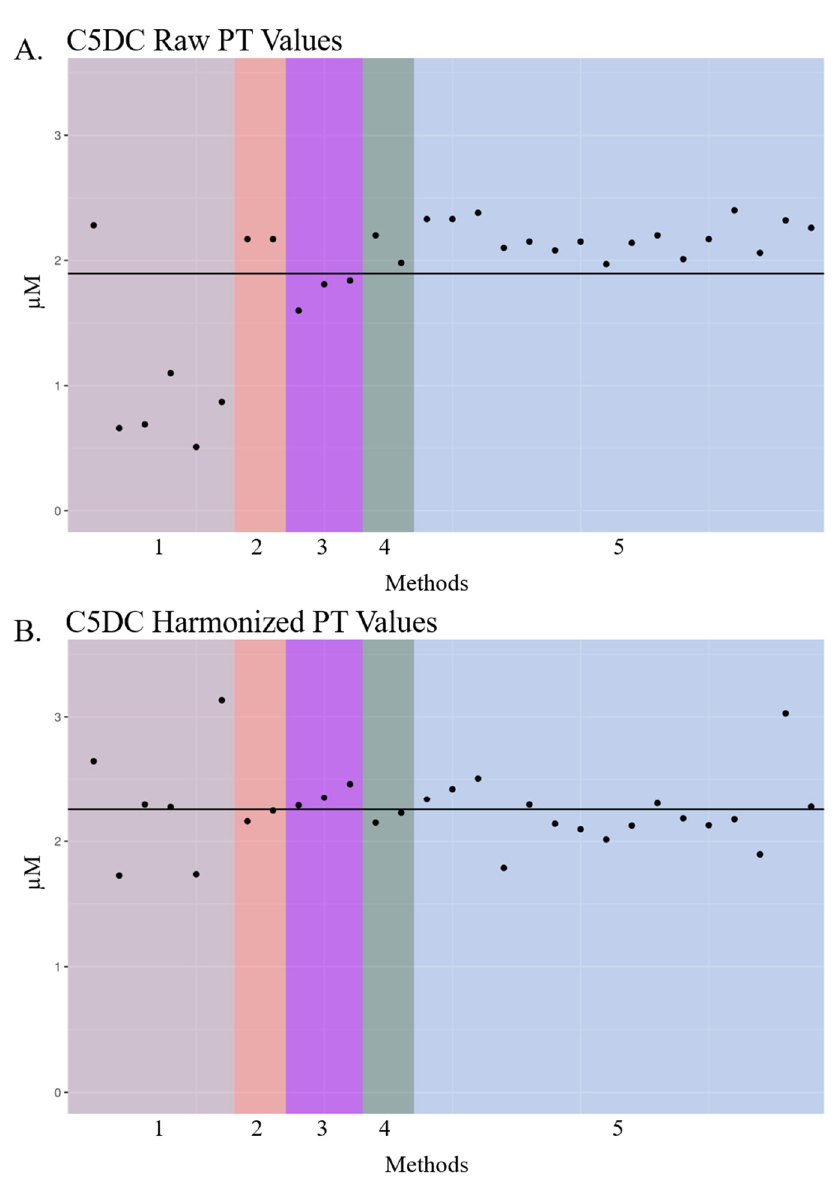
Figure 2. Dot plot of glutarylcarnitine (C5DC) proficiency test raw and harmonized data across US public health newborn screening (NBS) labs from 2019. Dot plots of raw ( A , B ) harmonized glutarylcarnitine (C5DC) proficiency test (PT) data reported by US public health NBS laboratories in 2019. Laboratory names are de-identified. Laboratory PT values are grouped by analytical method, and these unique methods are denoted by color and number. Each “ • ” indicates a unique US public health NBS laboratory’s PT concentration for C5DC. The black solid line represents the mean of PT values in each plot. Method 1: Derivatized—MS / MS LDT; Method 2: PerkinElmer NeoGram AAAC Tandem Mass Spectrometry kit (Waltham, MA, USA); Method 3: Perkin Elmer Neobase TM 2 Non-derivatized MSMS kit (Waltham, MA, USA); Method 4: Non-derivatized—MS / MS LDT; Method 5: Perkin Elmer Neobase TM Non-derivatized MSMS kit (Waltham, MA, USA).